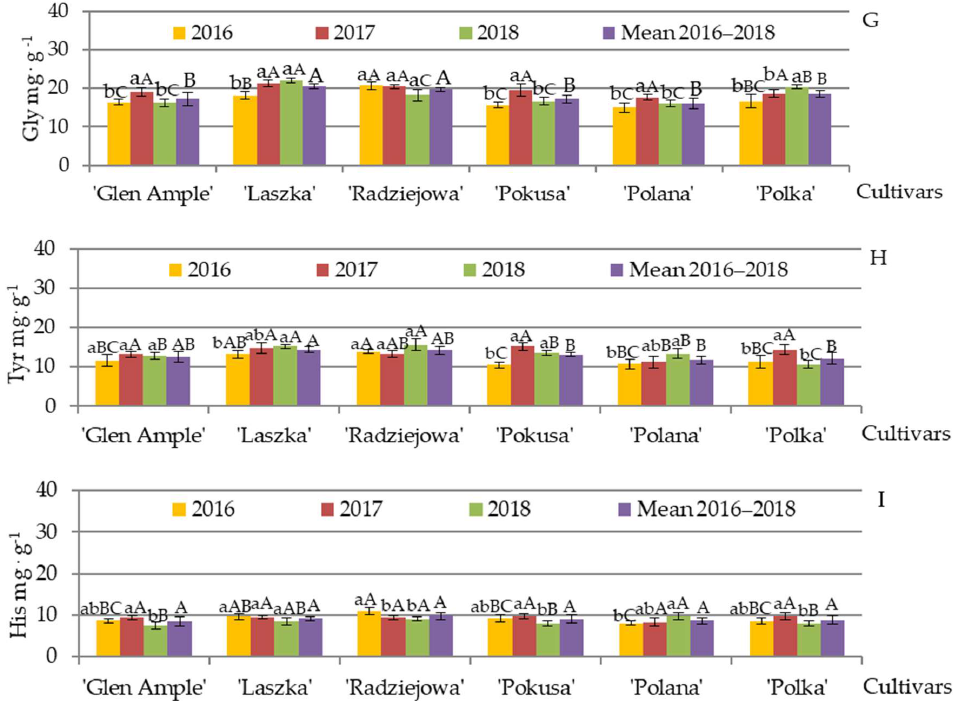
Figure 10. ( A–I ) . Content of endogenous amino acids in the pollen of R. idaeus cultivars. For explanations, see Figure 8 (number of repetitions in each year n = 3).